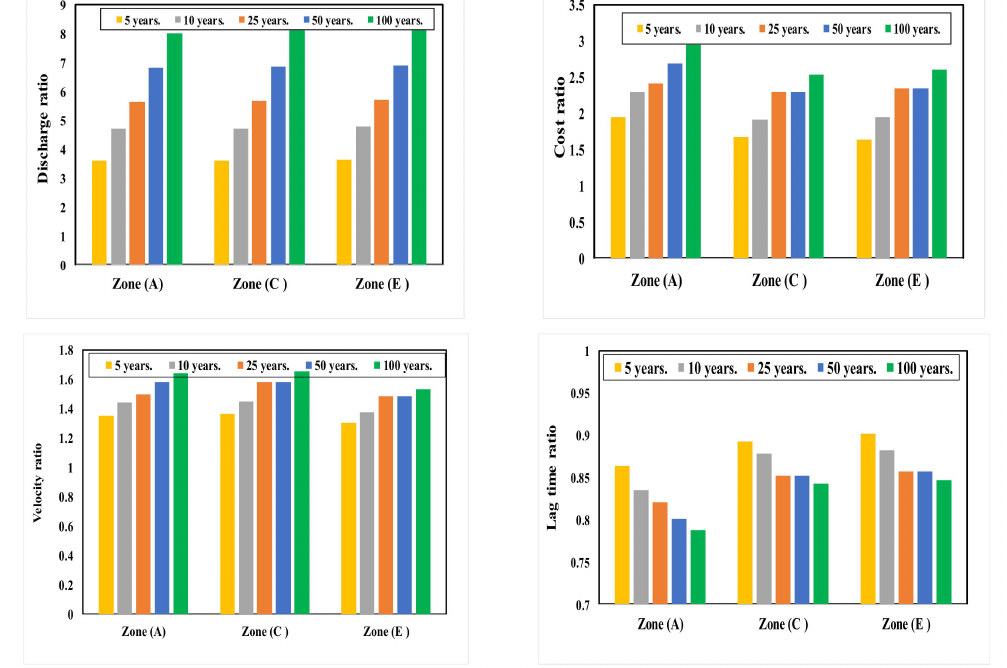
Figure 14. Comparison between discharges, cost, velocity and lag time for zones A, C and E at runo ff coe ffi cient (C =